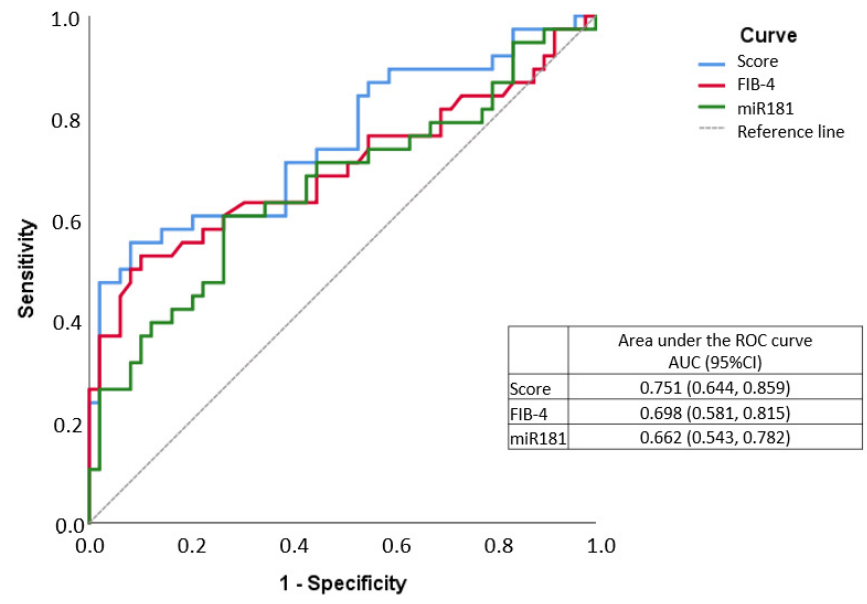
Figure 2. ROC curve of Fibrosis index-4 (FIB-4)/miR-181a score in fibrosis